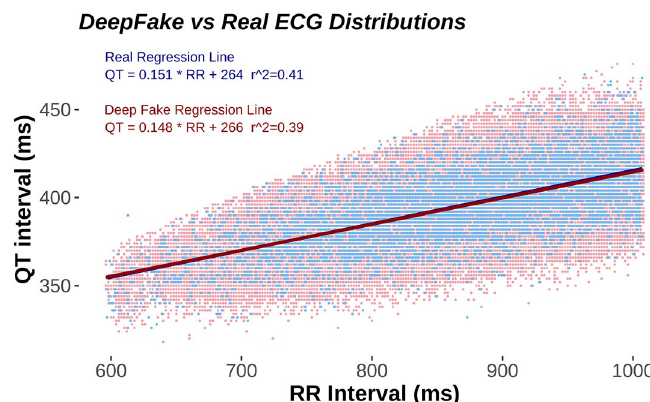
Figure 3. Scatter plot of the QT/RR interval relationship where Real ECG are shown in blue and normal DeepFakes in red. DeepFake dots are nudged 1 ms to the left for visibility. Note that there are 121,977 normal DeepFakes and only 7233 Real ECG making the DeepFake distribution more pronounced. As seen by the correlation coefficient r2, the real and the fake DeepFake ECGs are similarly